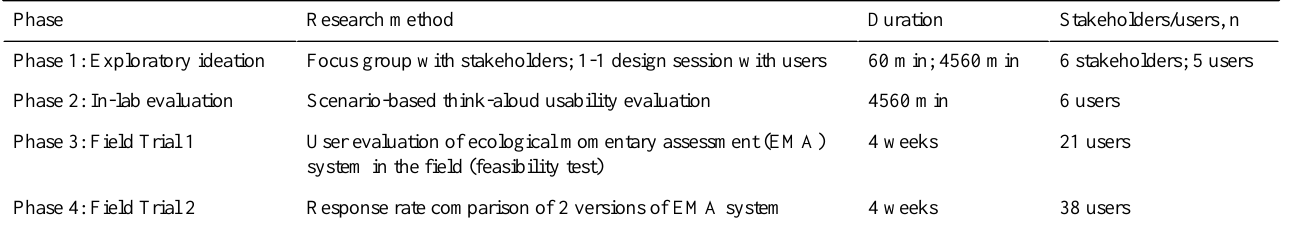
Table 1. Iterative and participatory user research and design of ecological momentary assessment system.